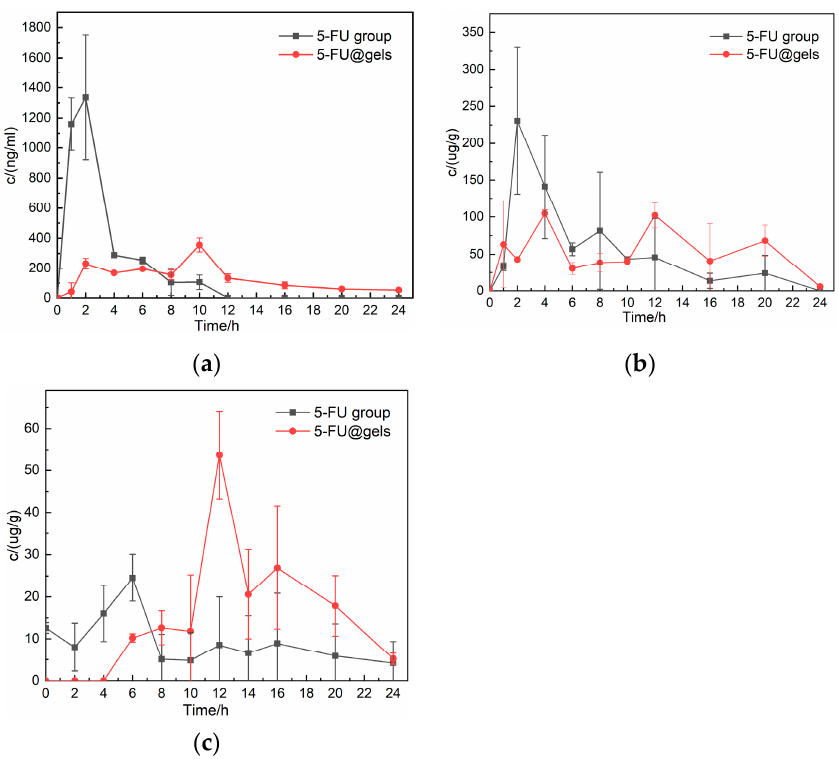
Figure 7. In vivo changes of 5-FU released by oral intragastric administration of 5-FU and 5-FU@gels ( a ; Serum, unit: ng/mL. b ; Contents of small intestine, unit: ug/g. c ; Colon contents, unit: ug/g).